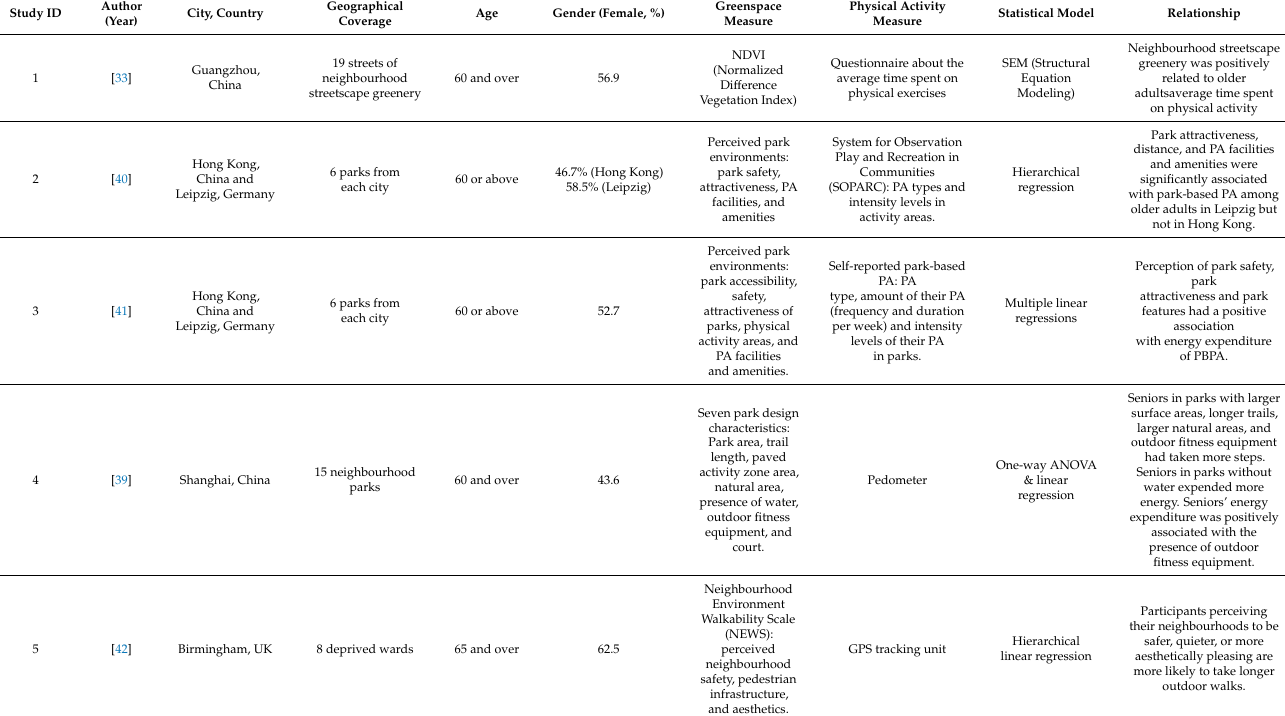
Table 3. Overview of the Included Studies based on PRISMA